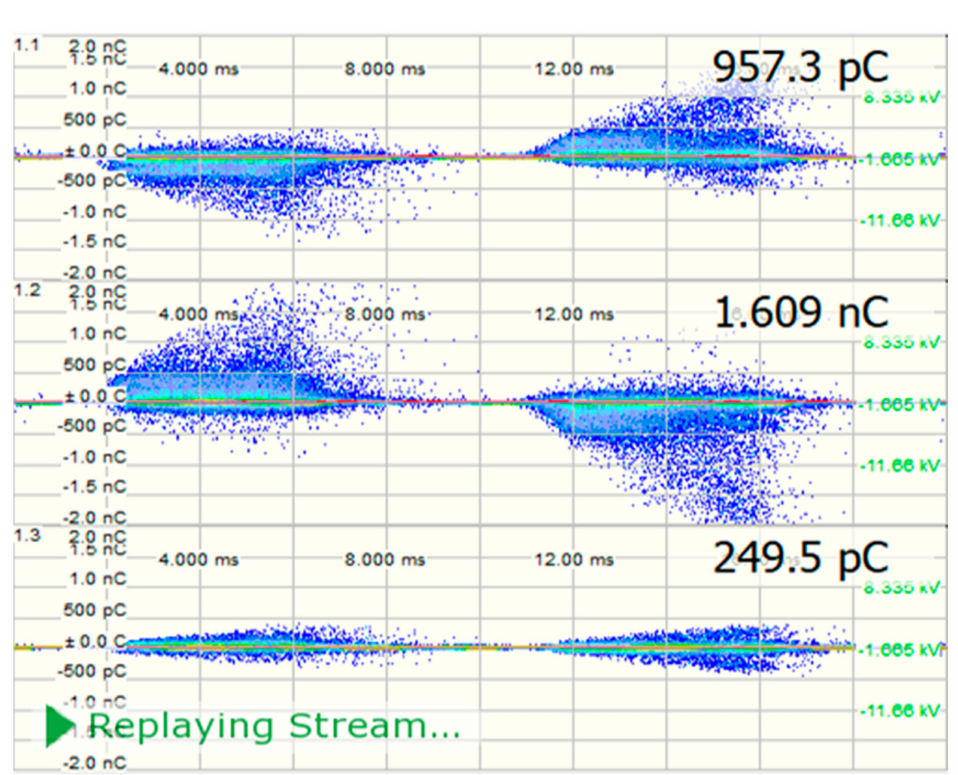
Figure 12. Synchronous multi-channel measurement and separation of